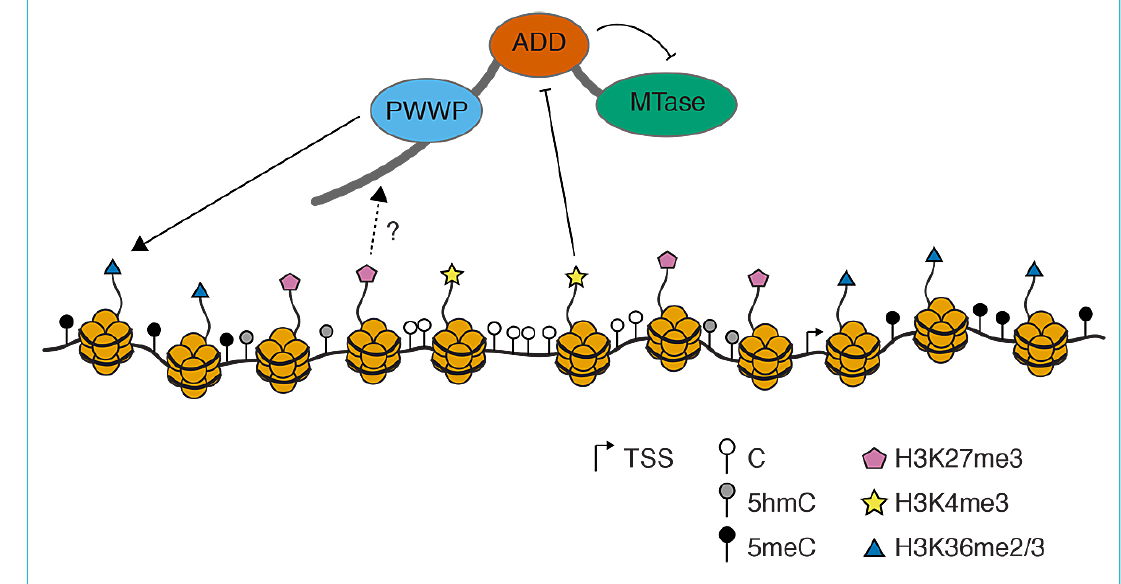
Figure 2: Histone tail modifications influencing DNMT3A/B recruitment to DNA. The PWWP domain recognises H3K36me2/3 (blue triangles), while the ADD domain is repelled by H3K4me3 (yellow stars). Additionally, the ADD domain auto-inhibits the MTase domain. How H3K27me3 (pink pentagon) influences DNMT3A/B recruitment remains to be elucidated. TSS = transcription start